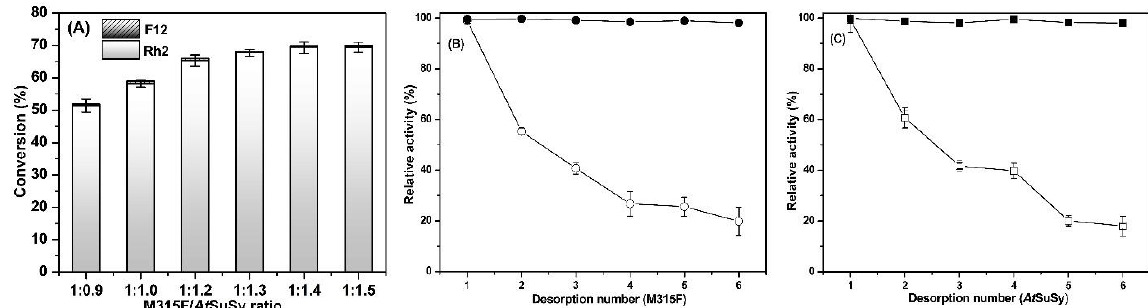
Figure 1. ( A ) Effect of the ratio of co-immobilized bienzyme M315F/ At SuSy for Rh2 production. The yield of products Rh2 and F12 was recorded. ( B ) Desorption of immobilized M315F, his-tagged M315F directly specifical binding with Ni 2+ -chelate groups ( ○ ), co-immobilized M315F by affinity adsorption and covalently cross-linking (●). ( C ) Desorption of co-immobilized At SuSy, his-tagged M315F directly specifical binding with Ni 2+ -chelate groups (□), co-immobilized M315F by affinity adsorption and covalently cross-linking ( ■ ). Enzyme desorption was conducted by measuring the enzyme activity in supernatant and suspension with 0.5 M NaCl solution (pH 7.0), the suspension was maintained under very gentle stirring for 60 min.